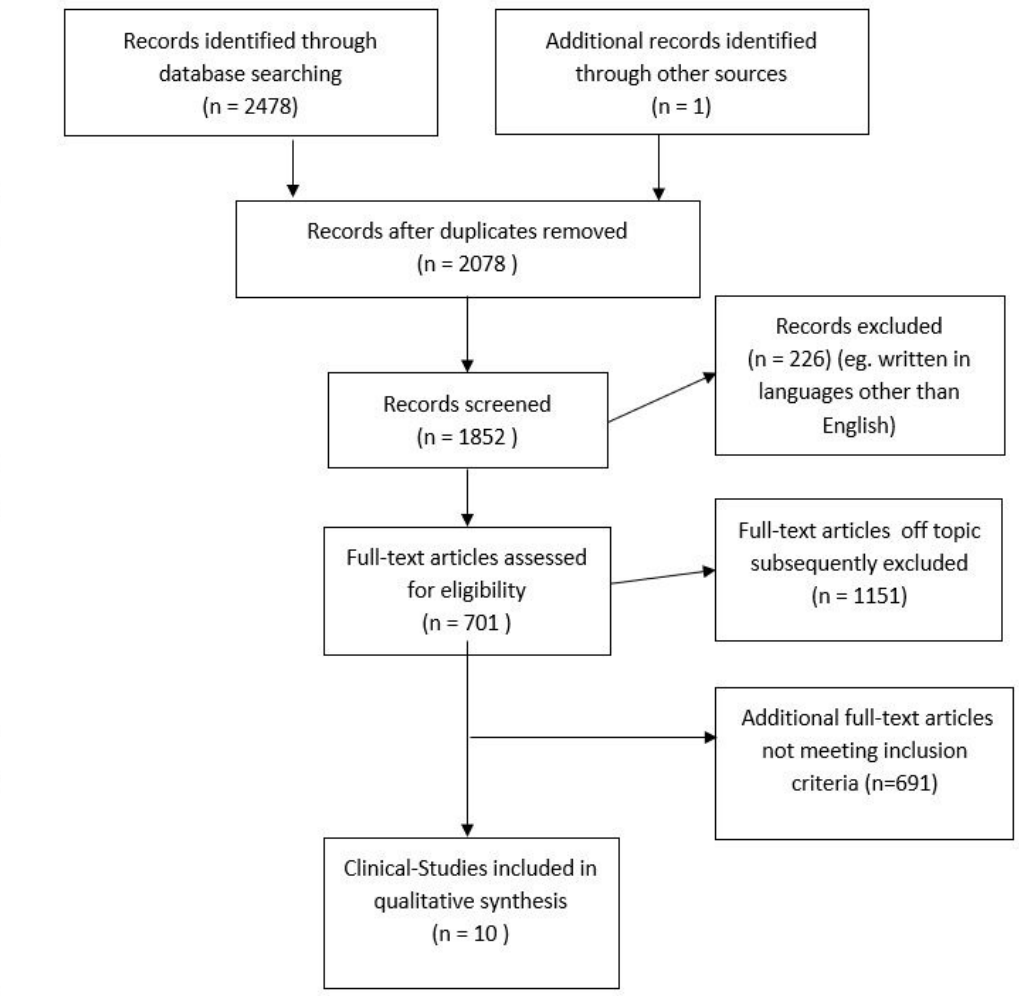
Figure 1. Stages of the screening process about BUP and depression.